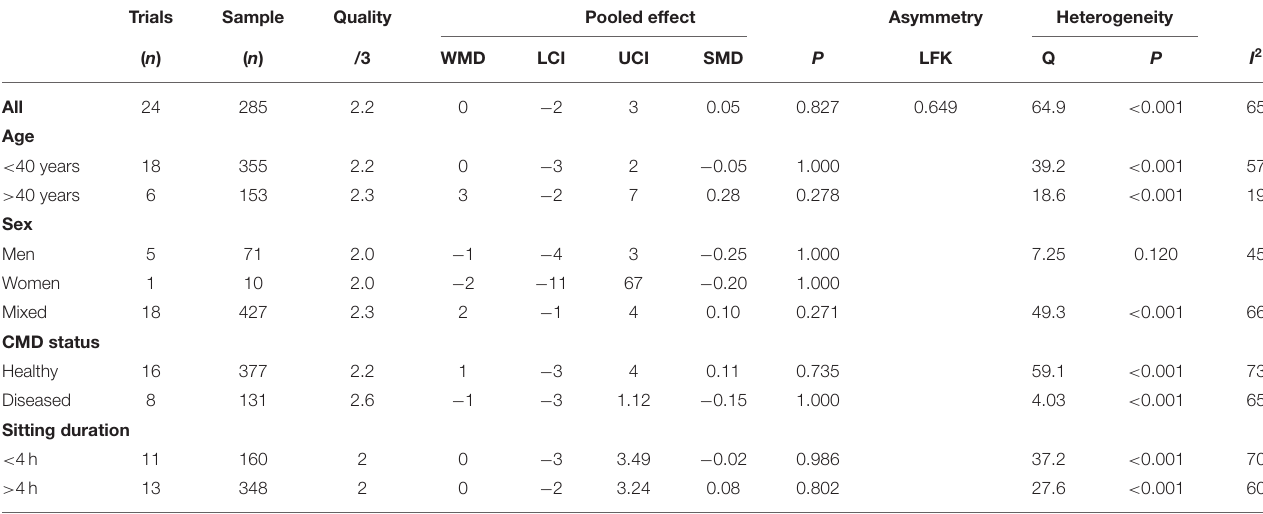
TABLE 2 | The effect of prolonged sitting on heart rate. Trials Sample Quality Pooled effect